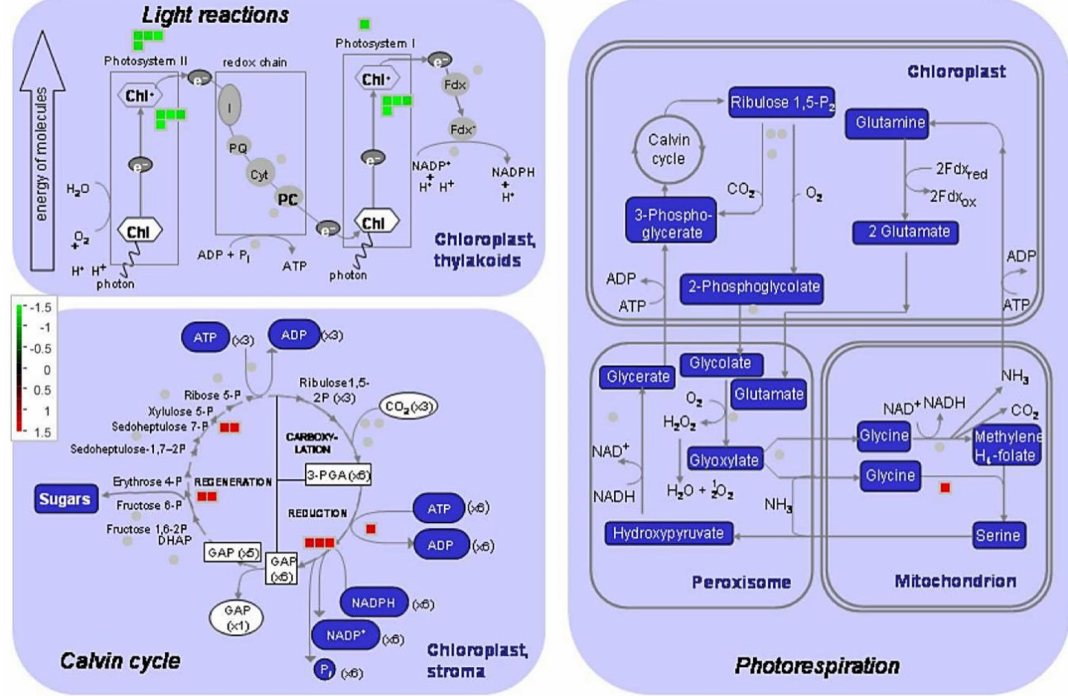
Figure 6. Diagram showing the changes in abundance of photosynthesis-related proteins in banana ( Musa spp. AAA) in response to a low temperature of 10 ◦